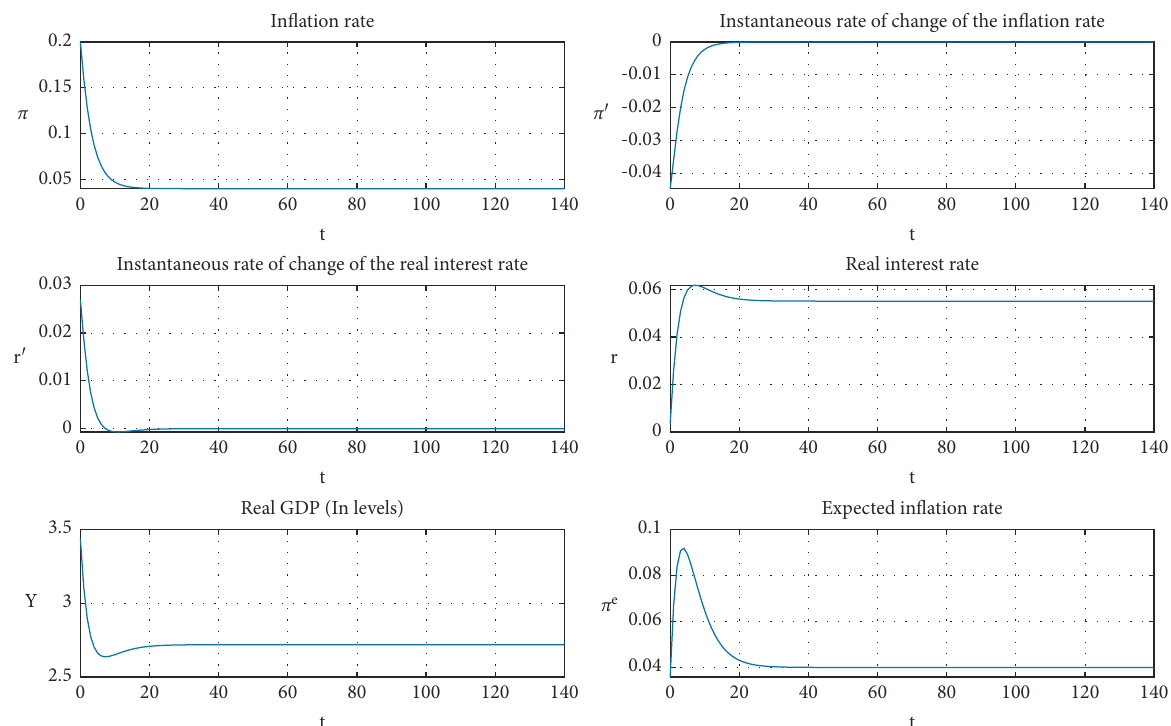
Figure 9: Time paths of the interest rate, real GDP, inflation, expected inflation, and instantaneous rates of change of the interest rate and